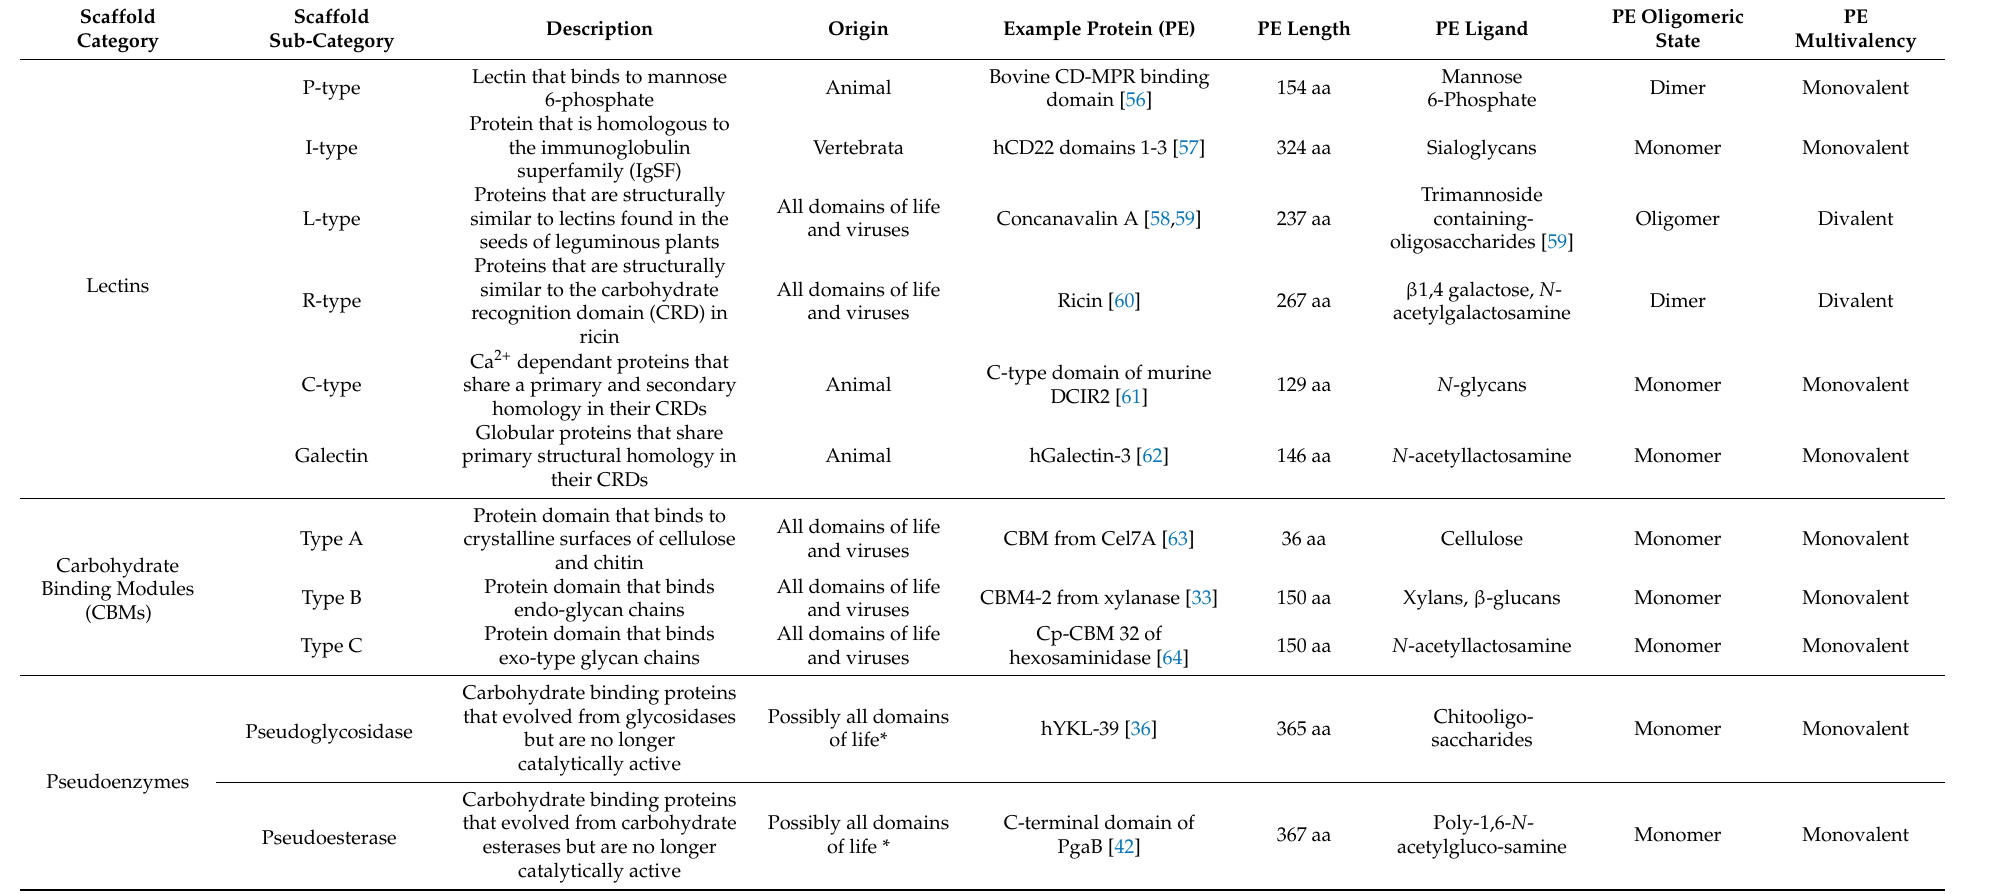
Table 1. Carbohydrate binding proteins (CBPs) with available structural and ligand binding